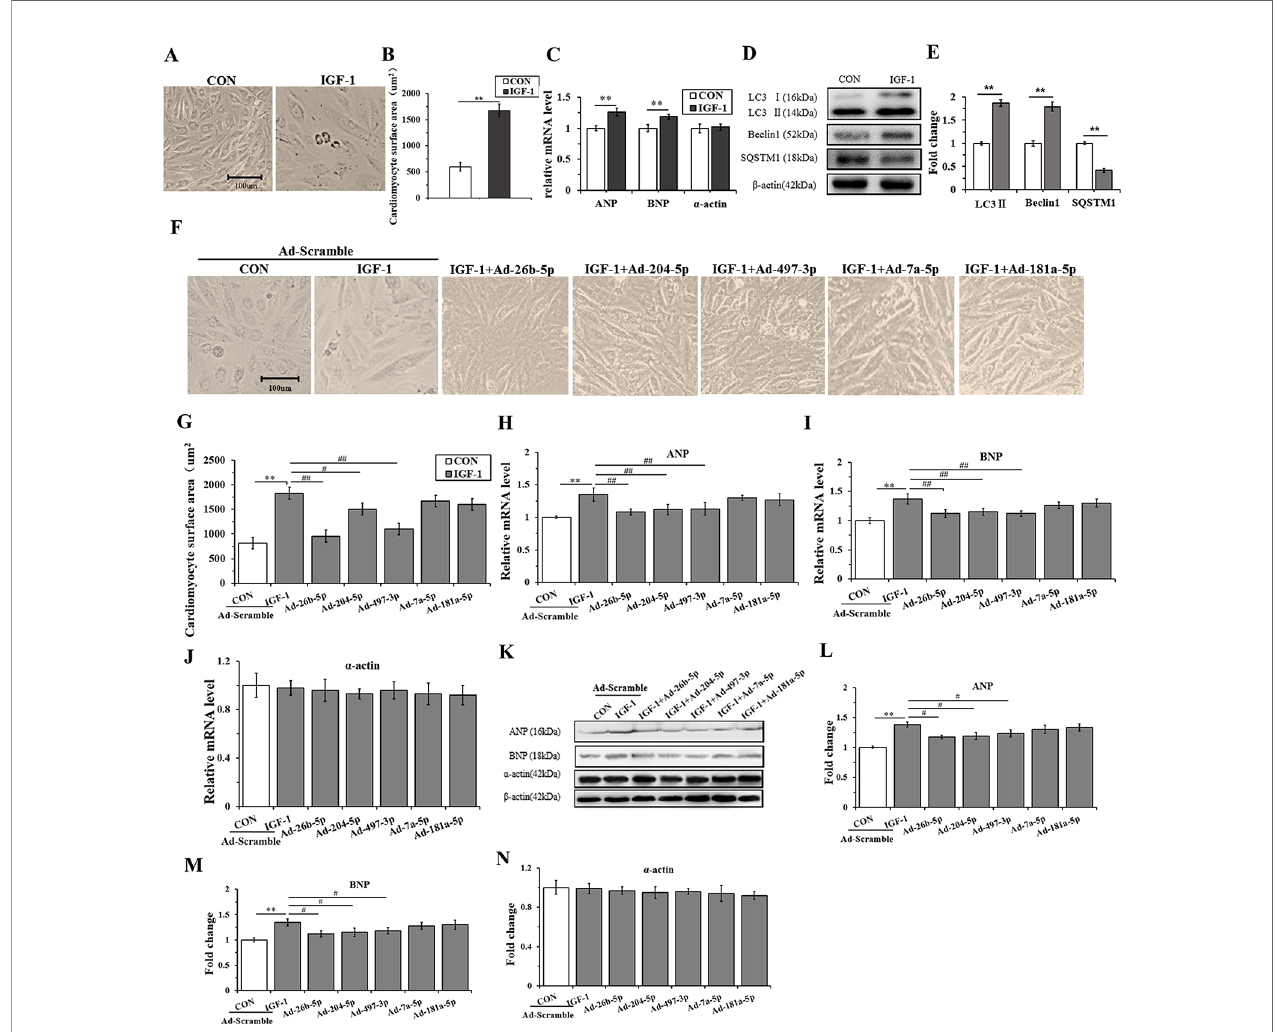
FIGURE 4 | Overexpression of miR-26b-5p, miR-204-5p, and miR-497-3p attenuates IGF-1 induced cardiomyocyte hypertrophy. (A, B) , The morphology of H9C2 cells treated with IGF-1 (10 µM)for 48 h. (C) , The messenger RNA (mRNA) levels of atrial natriuretic polypeptide (ANP), brain natriuretic peptide (BNP), and a -actin in H9C2 cells treated with IGF-1 (10 µM). (D, E) , The protein expression of autophagy maker (LC3B, Beclin1, and SQSTM1) of H9C2 cells treated with IGF-1 (10 µM). (F, G) , Cardiomyocyte surface area of H9C2 cells in response to IGF-1 (10 µM) with adenovirus-mediated microRNA (miRNA) infection. (H – J) mRNA levels of cardiomyocyte hypertrophy makers of H9C2 cells treated with IGF-1 (10 µM) and adenovirus mediated miRNAs. (K – N) Protein levels of cardiomyocyte hypertrophy makers of H9C2 cells treated with IGF-1 (10 µM) and adenovirus mediated miRNAs. ** P < 0.01, IGF+scramble (n=6) vs . CON+scramble group (n=6). # P < 0.05, ## P < 0.01, miRNA adenovirus intervention group (n=6) vs . IGF-1+scramble group (n=6). Data are presented as means ± SD. Statistical signi fi cance was evaluated with the two-tailed Student's t test (B , C , E) and one-way analysis of variance with Bonferroni post-hoc analysis (G – J , L – N)